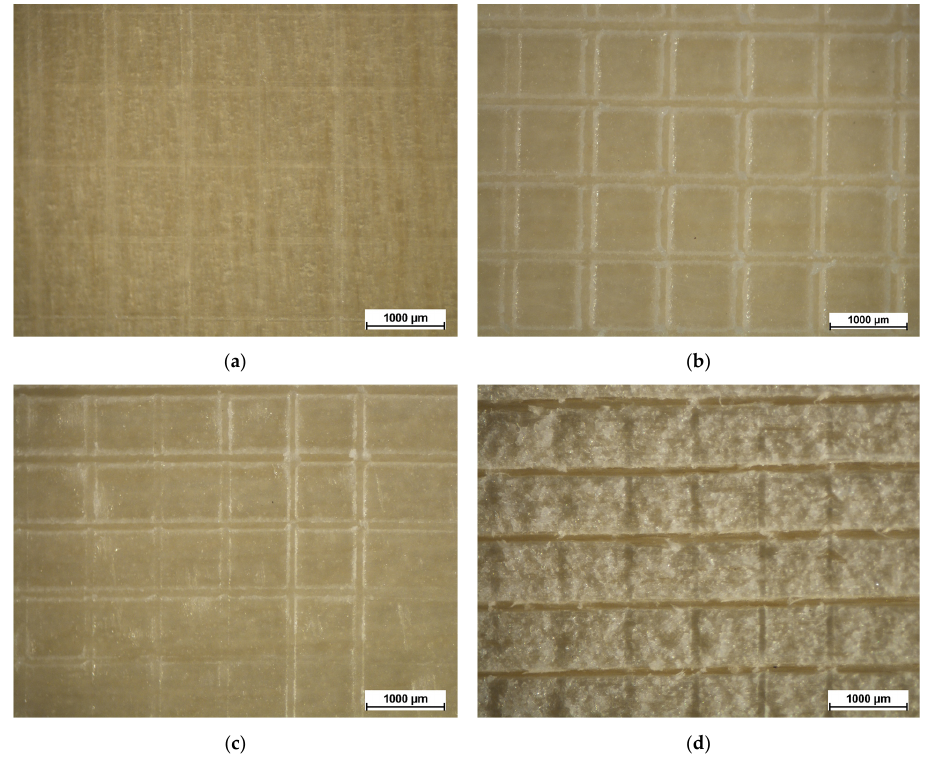
Figure 7. Cross Cut Test results after exposure to the climatic chamber of ( a ) sample F0, ( b ) sample F5, ( c ) sample F10 and ( d ) sample F20, observed with optical microscope.